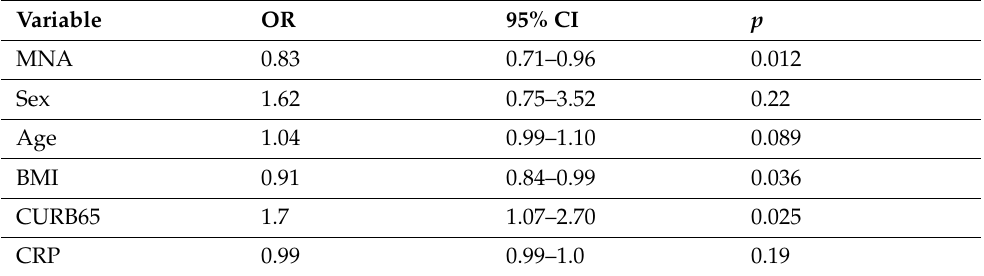
Table A3. Multivariate analysis for one-year mortality: the MNA value.